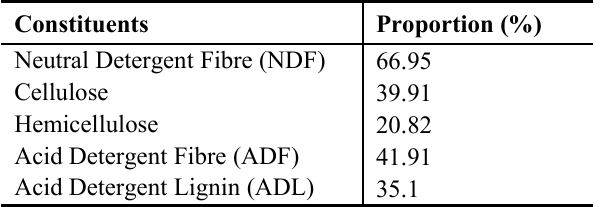
Table 3. Characterization of the crude fibre fractions of Elephant grass ( Pennisetum purpureum ).